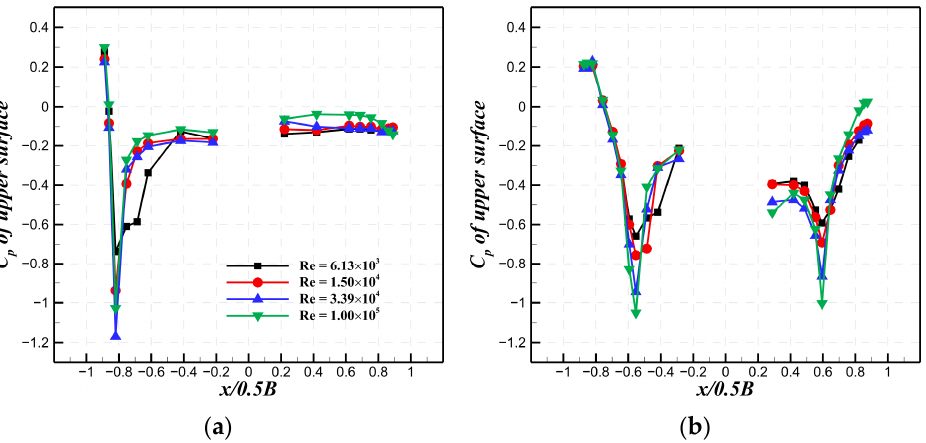
Figure 8. The mean surface pressure distribution of the twin-box girder at different Re: ( a ) the pressure surface distribution of the upper surface, and ( b ) the pressure surface distribution of the lower surface.